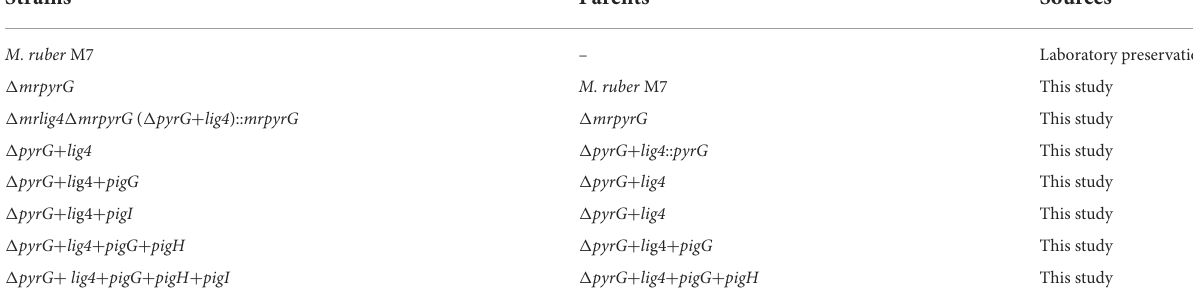
TABLE 1 Monascus ruber strains used and constructed in this study.